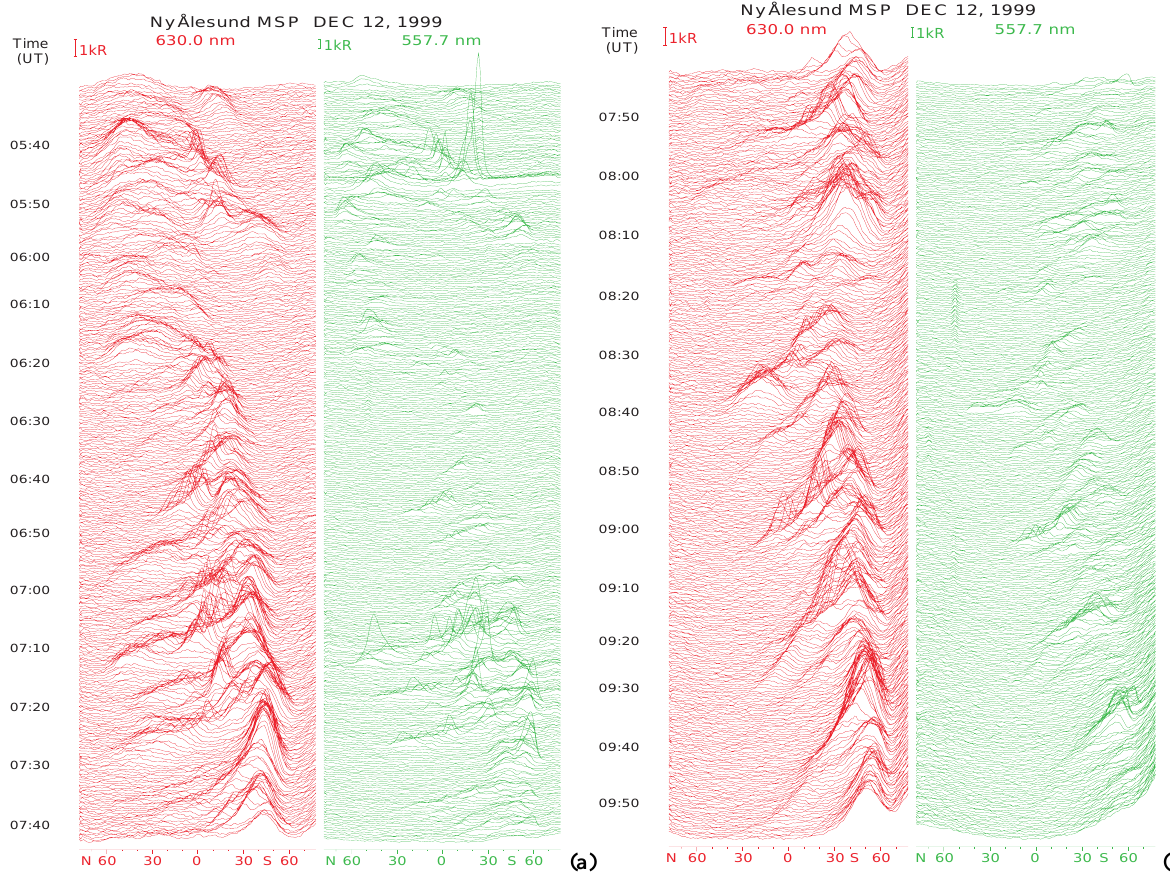
Figure 17a Fig. 17. MSP observations from Ny ˚Alesund during the intervals (a) 05:30–07:40 UT and (b) 07:40–09:55 UT. Left and right columns show stacked plots of line of sight intensity vs. zenith angle for the wavelength channels at 630.0 and 557.7nm, respectively. Same format as in Fig.